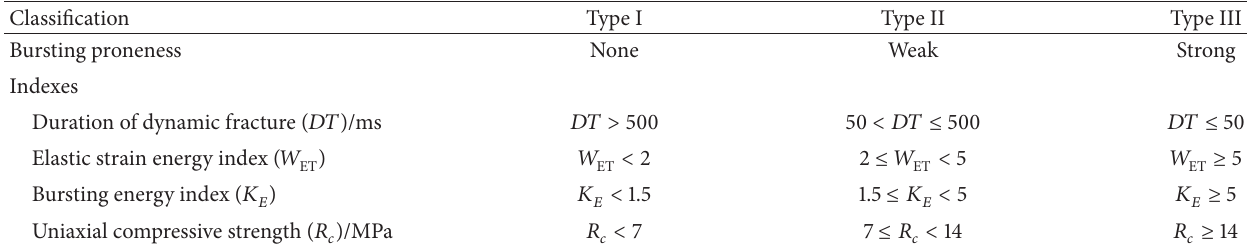
Table 2: Classification of bursting proneness of coal.